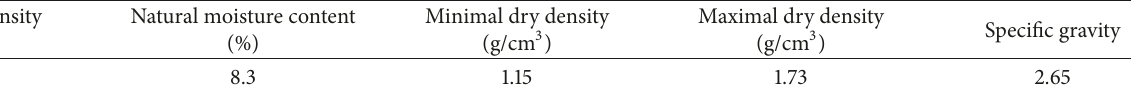
Table 2: Material parameters of the sand.